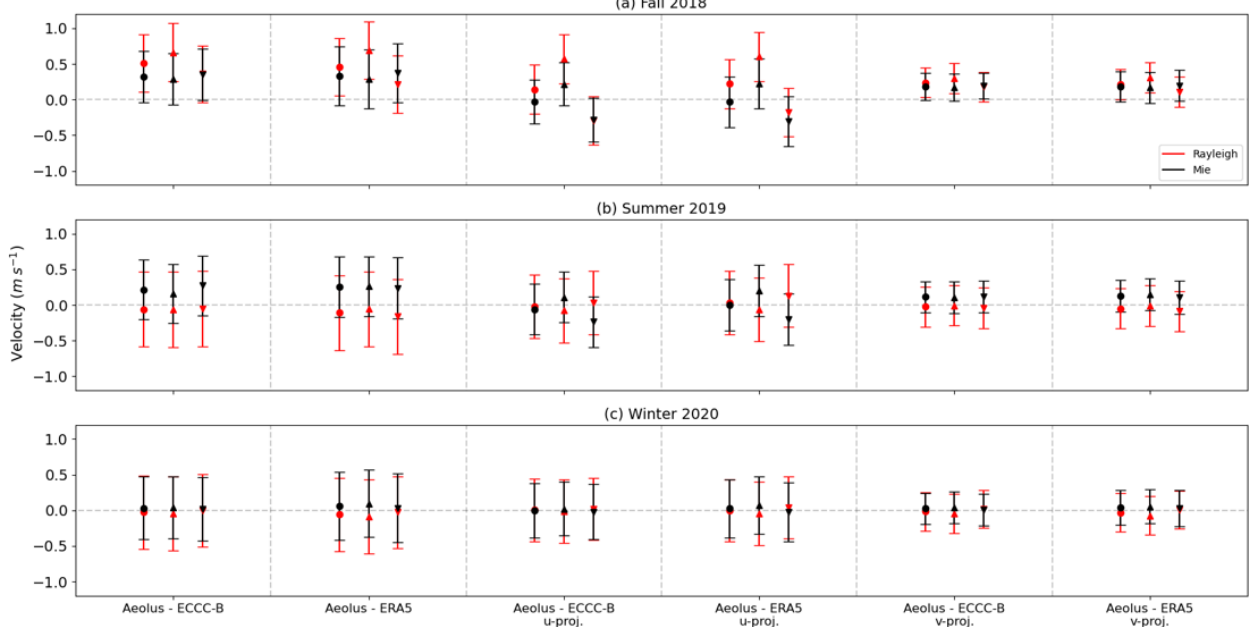
Figure 9. Means (10 0 ) and standard deviations (10 1 ) of the distributions of the differences between Aeolus Rayleigh (Mie) winds and ECCC- B and ERA5 shown as red (black) dots or triangles and error bars over the Arctic during (a) boreal autumn 2018, (b) summer 2019, and (c) winter 2019–2020. The dots represent Aeolus measurements in the atmosphere which can be decomposed into ascending (upright triangles) and descending (inverted triangles) measurements. The distributions of the differences of the projected winds are shown in the latter four